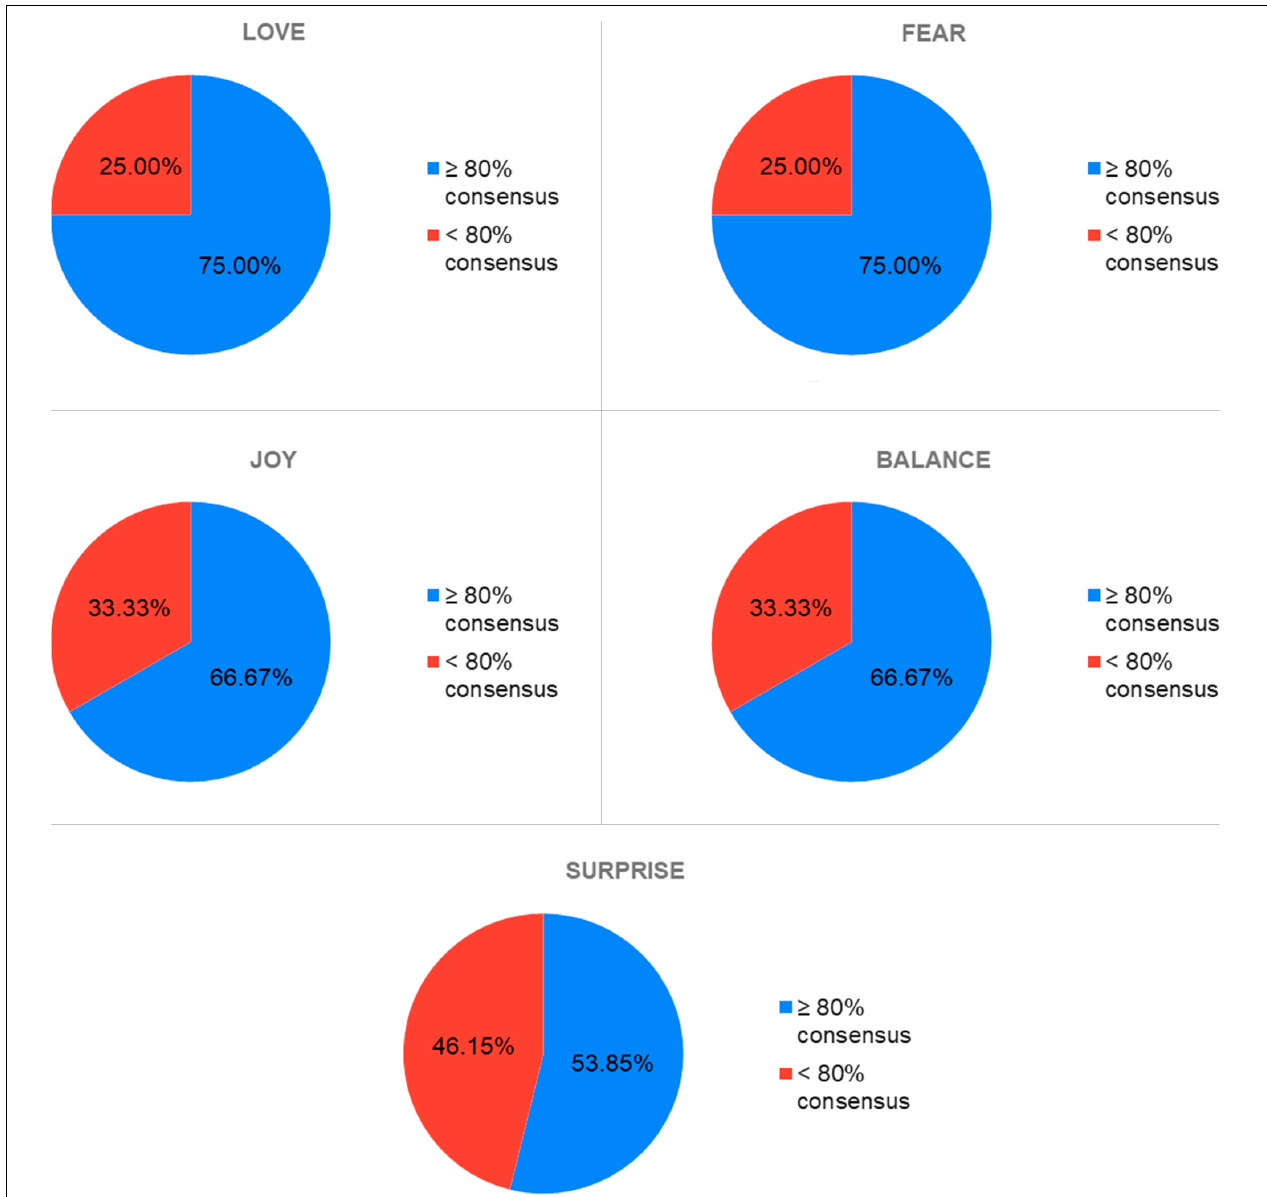
FIGURE 10 | Consensus percentages obtained for the emotions of love, fear, joy, balance, and